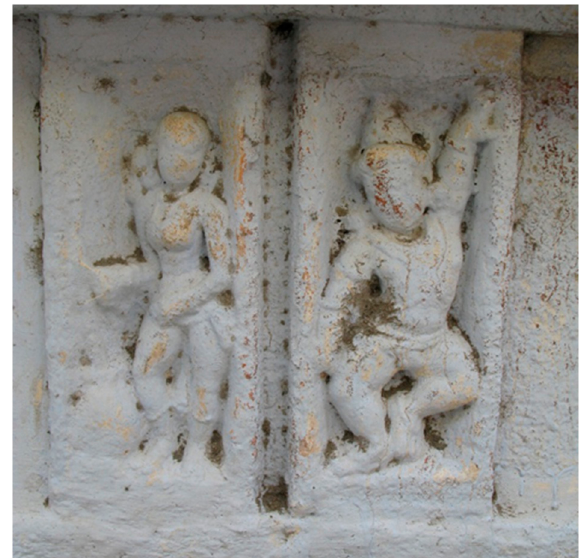
Figure 16. K ṛṣṇ a dancing under the eye of one churning milkmaid. Figure 16. Kr.s.n.a dancing under the eye of one churning